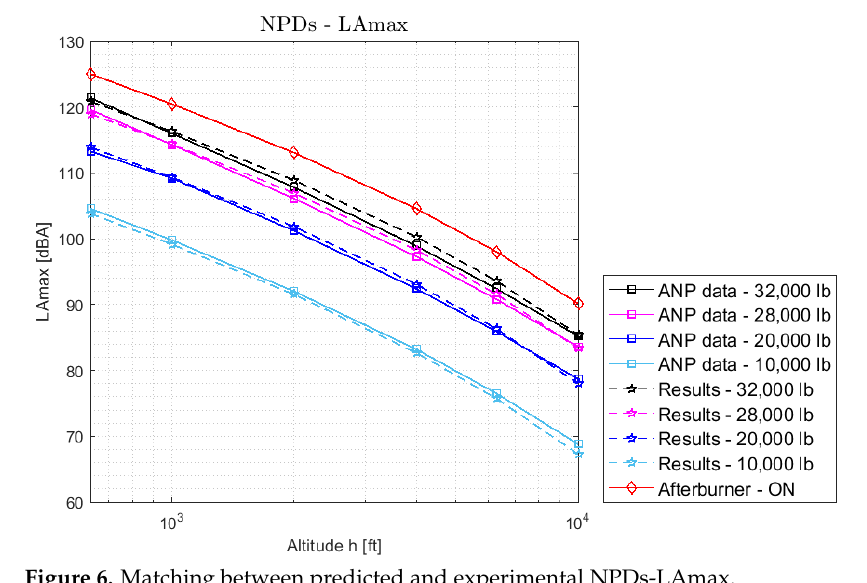
Figure 6. Matching between predicted and experimental NPDs-LAmax.